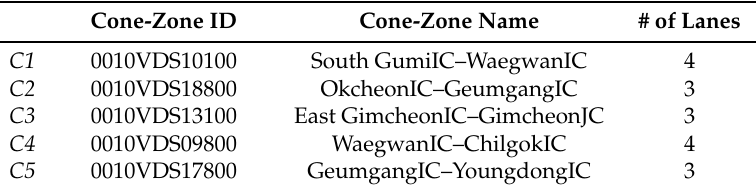
Table 1. Details of the five cone zones used in these experiments.